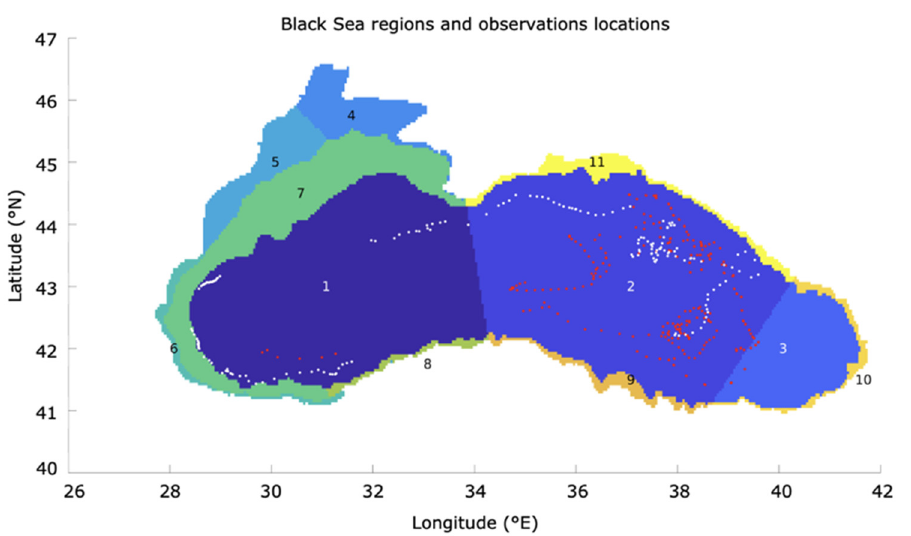
Table 4. BIAS (cid:2922)(cid:2925)(cid:2917)(cid:2869)(cid:2868) statistics for chlorophyll obtained for BS-BIO NRT, considering the observation minus model prediction pairs for the various regions (1–11) shown in Figure 8 Data are from the L3 CMEMS satellite chlorophyll observations (Table 1).